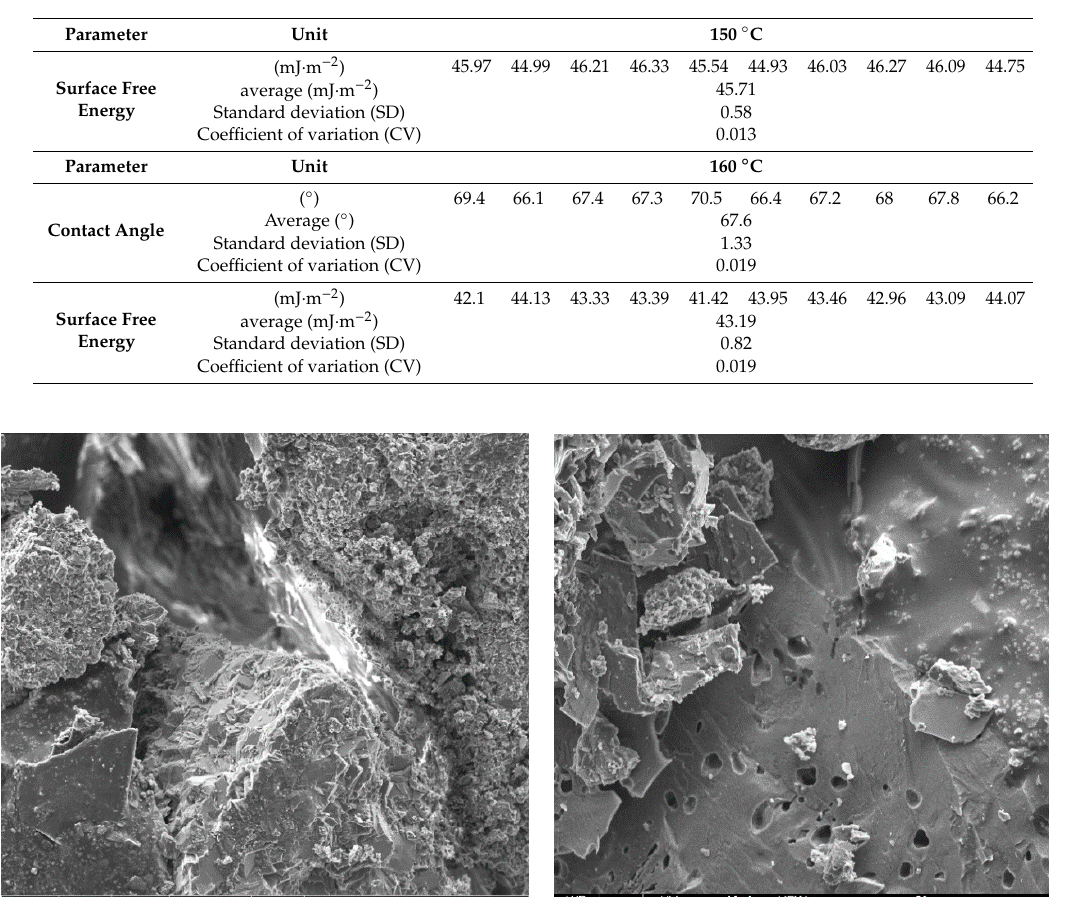
( b ) Figure 6. Contact angle of a water drop in mineral–asphalt mixtures: ( a ) WC-1; ( b ) WC-2.